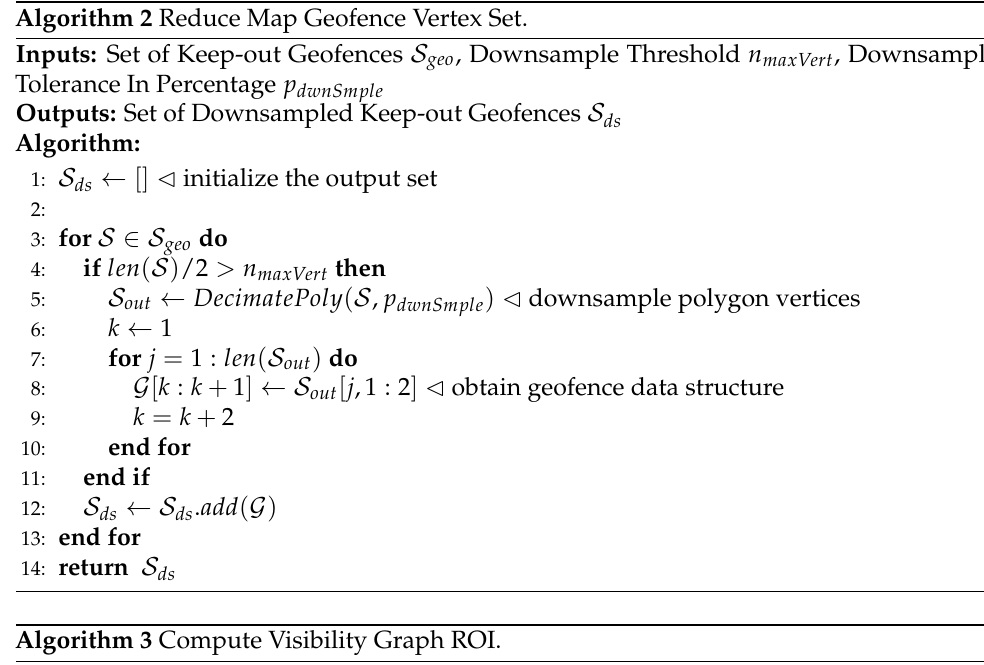
Algorithm 3 Compute Visibility Graph